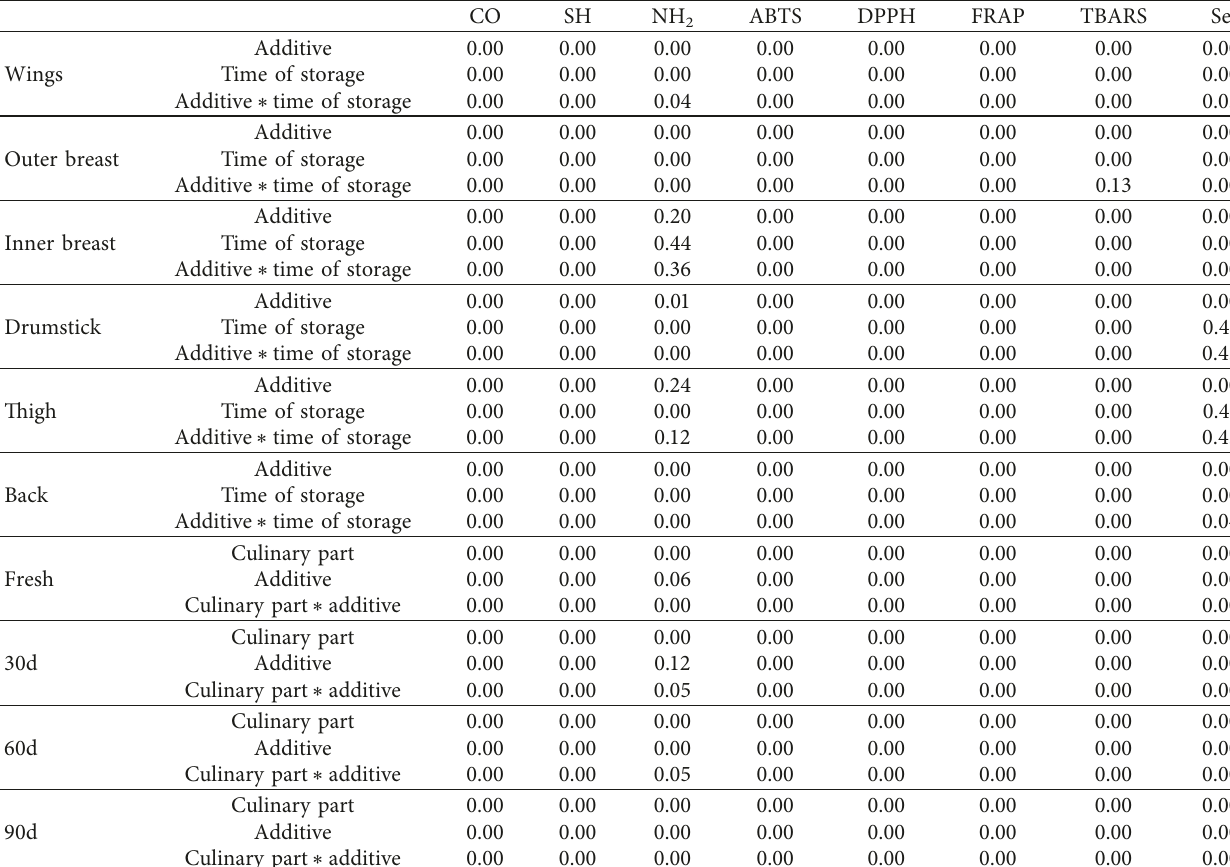
Table 3: Statistical significance p > 0 . 05 for the content of the chemical reactive groups in the myofibrils proteins, antioxidative potential, and selenium content of chicken culinary parts after supplementation with selenium during frozen storage. CO Additive ∗ time of